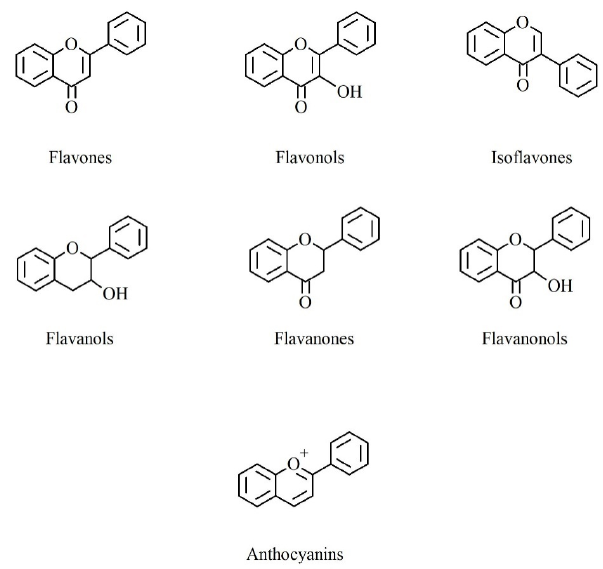
Figure 1. Basic structure of the main different subclasses of flavonoids.